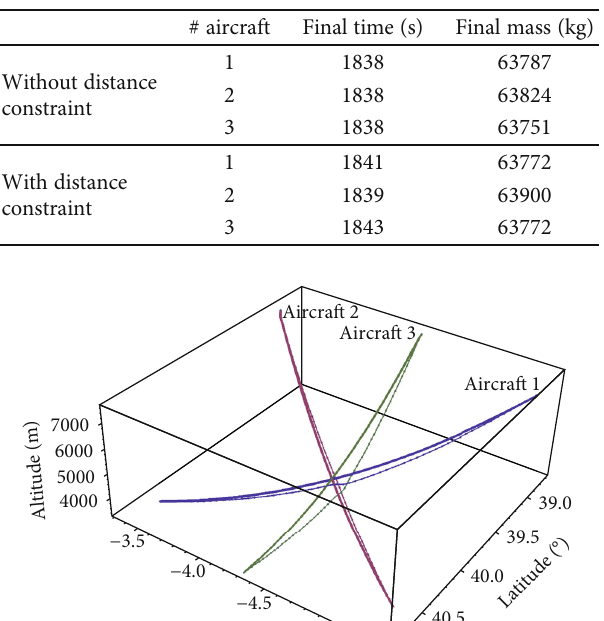
Table 5: Results of Experiment 2.